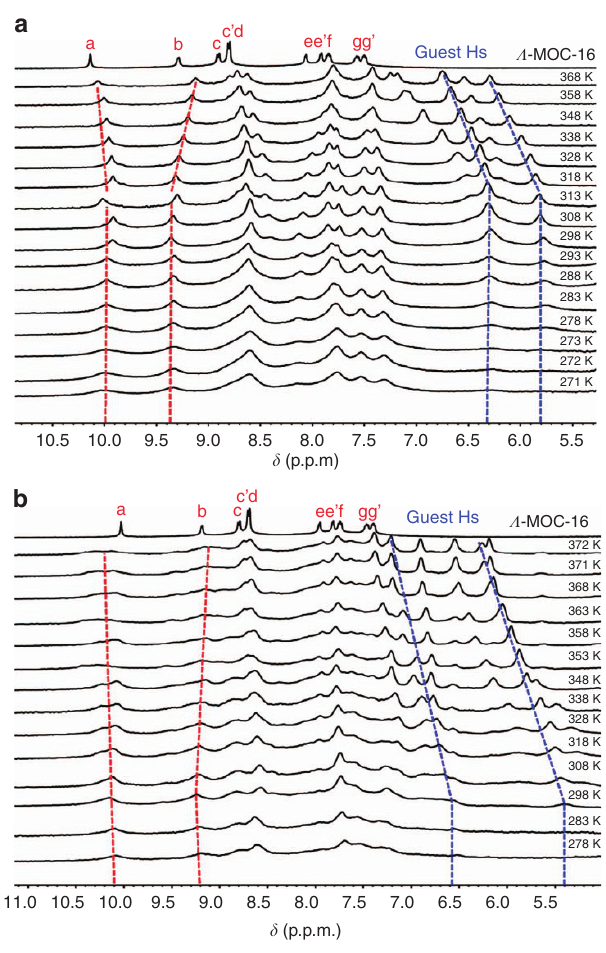
Figure 6 | VT 1 H NMR study of guest inclusion dynamics in solvent DMSO-d 6 /D 2 O ¼ 1/5. ( a ) R -BINOL C L -MOC-16. ( b ) S -BINOL C L -MOC- 16. Red lines show host protons, while blue lines show guest protons.